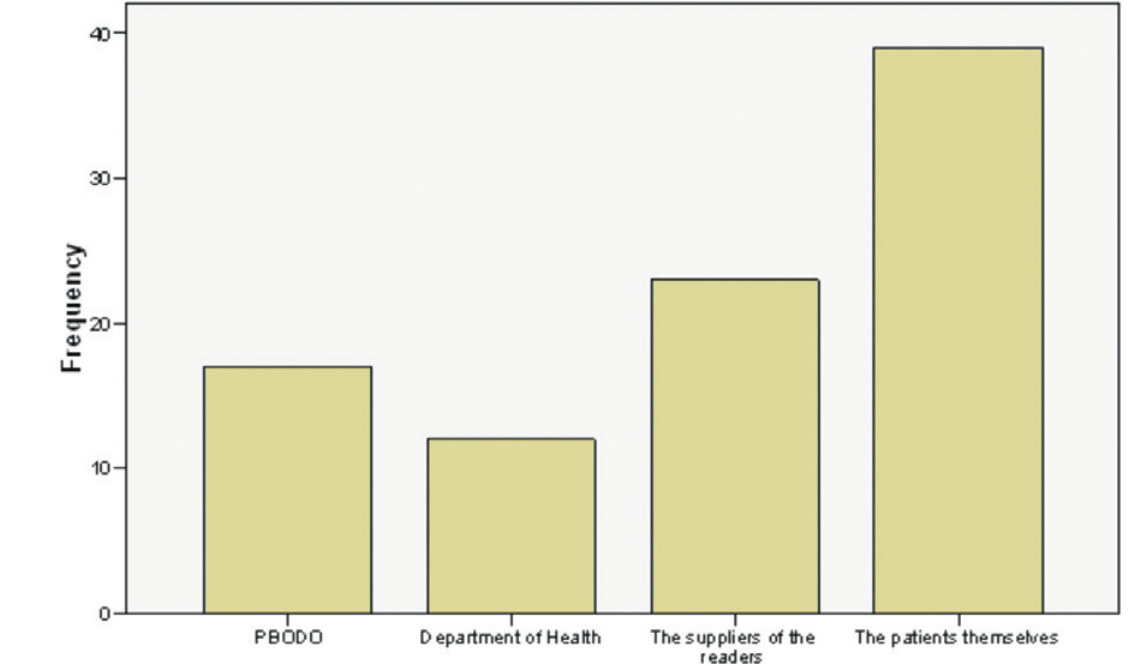
Figure 4: Responsibility for untreated pathology by ready-made readers